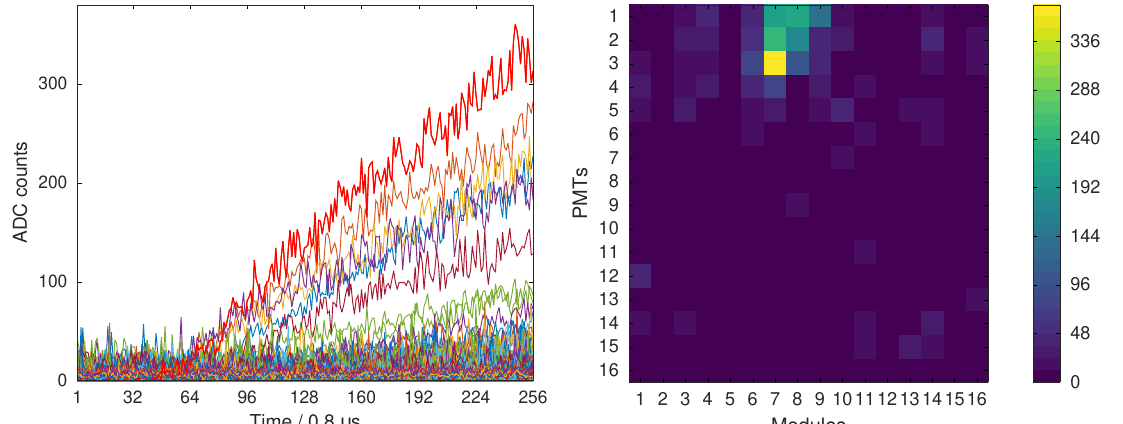
Figure 8. Slow flash with strongly nonuniform illumination of the focal surface. Left : waveforms. Right : a snapshot of the focal surface at the moment of the maximum signal.